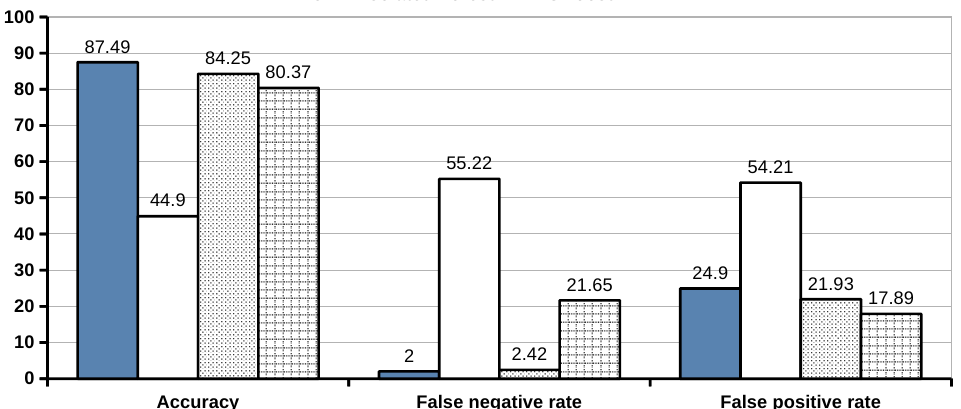
Figure 14. Comparison of classification between ANC and other algorithms in UNSW-NB15 dataset.